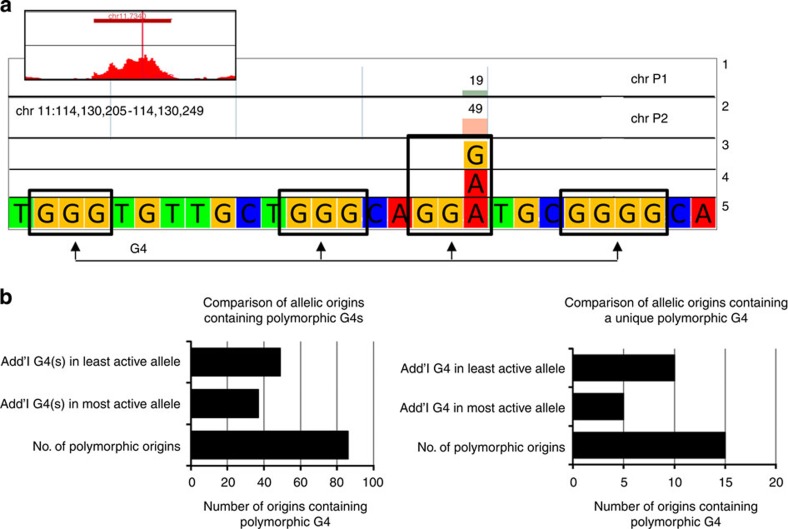
Number of G4s in allele-biased origins does not correlate with origin usage.(a) A G4 quadruplex at position 114,130,205–1,114,130,249 on chr 11 is present on chr P1 but not on chr P2 because of a G to A transition that destroys the third triplet of Gs. Tracks 1 and 2 illustrate the number of reads containing a G or an A at that position. Tracks 3 and 4 illustrate an SNP that alters a G4-forming sequence. Track 5 illustrates the sequence of the G4. Black rectangles highlight the four triplets of G and the G to A SNP. (b) Presence of G4s does not correlate with origin activity. Left histogram: x axis, number of origins containing one or more polymorphic G4. Right histogram: same but restricted to origins containing at most 1 G4. Additional G4s created by SNPs or indels are about equally distributed between the least and most active alleles.